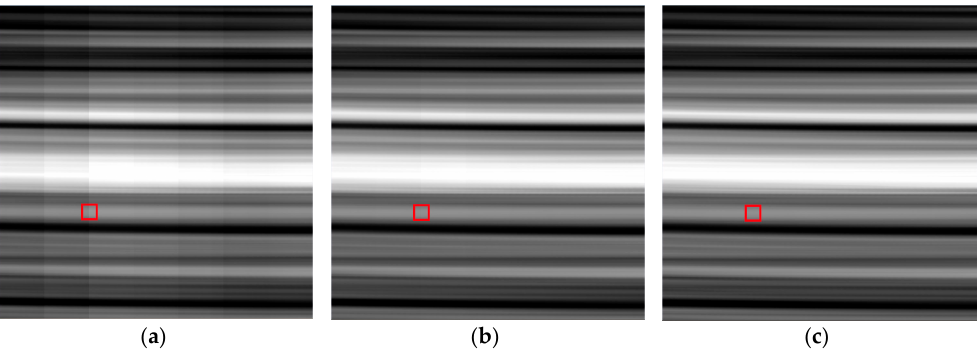
Figure 6. The results of relative radiometric correction. ( a ) Standard data that resulted from data pre-processing of the raw side-slither data; ( b ) Result of using on-orbit coefficients; ( c ) Result of using side-slither coefficients.